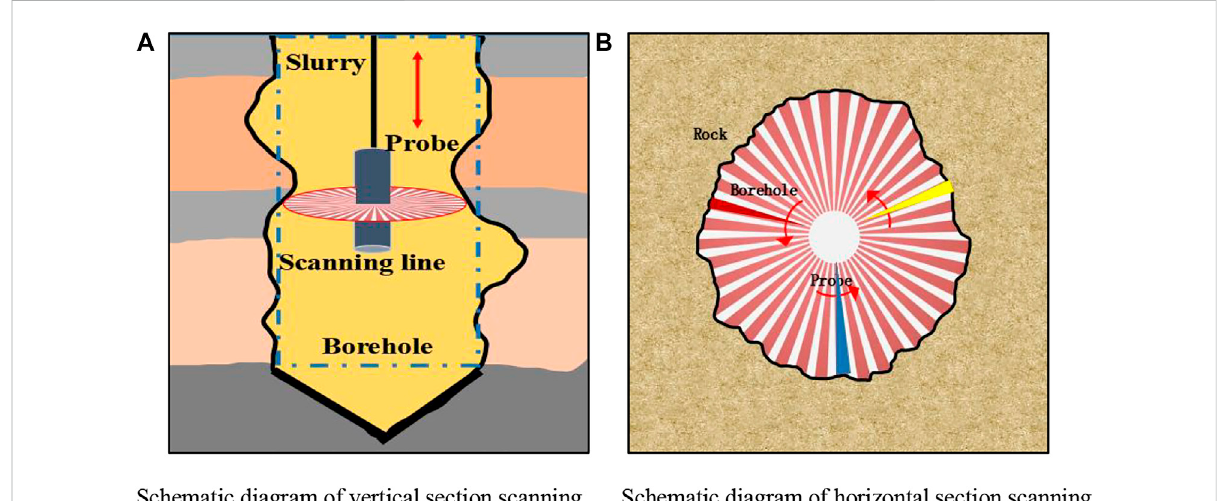
FIGURE 2 Schematic diagram of multi-array ultrasonic scanning principle.